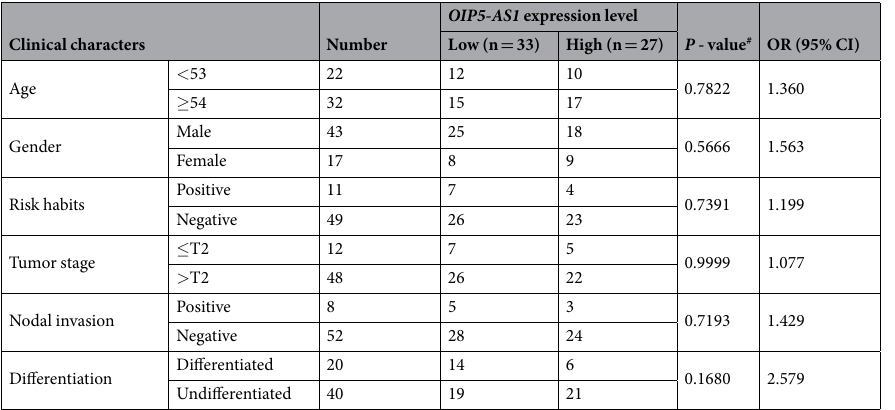
Table 1. Relationship between OIP5-AS1 expression and clinicopathological characteristics in oral cancer patients. # Fisher’s exact test with two tailed P